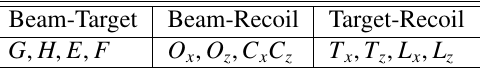
Table 1: Double Polarization observables can be divided into three groups